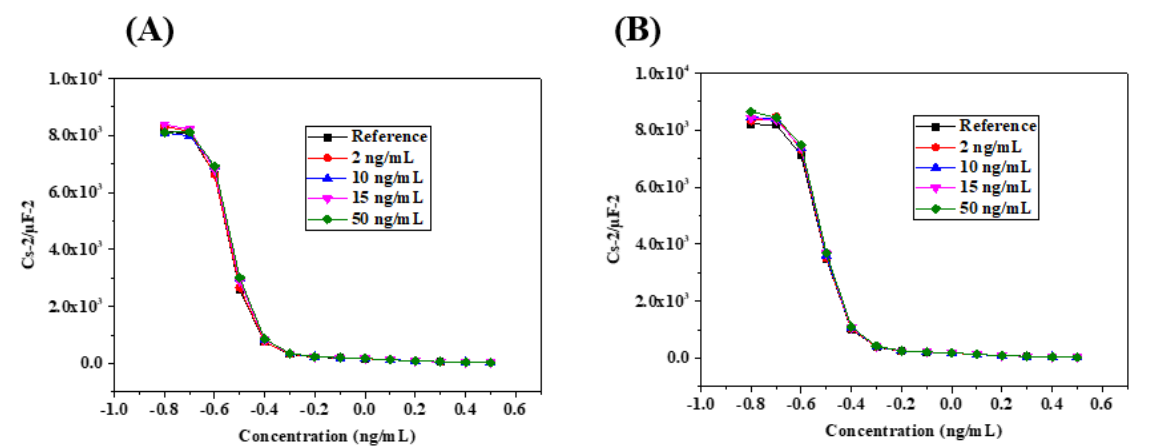
Figure 10. ( A ) Capacitance–voltage plots for TNF- α detection; ( B ) for NT-proBNP detection using the capacitive immunosensor.